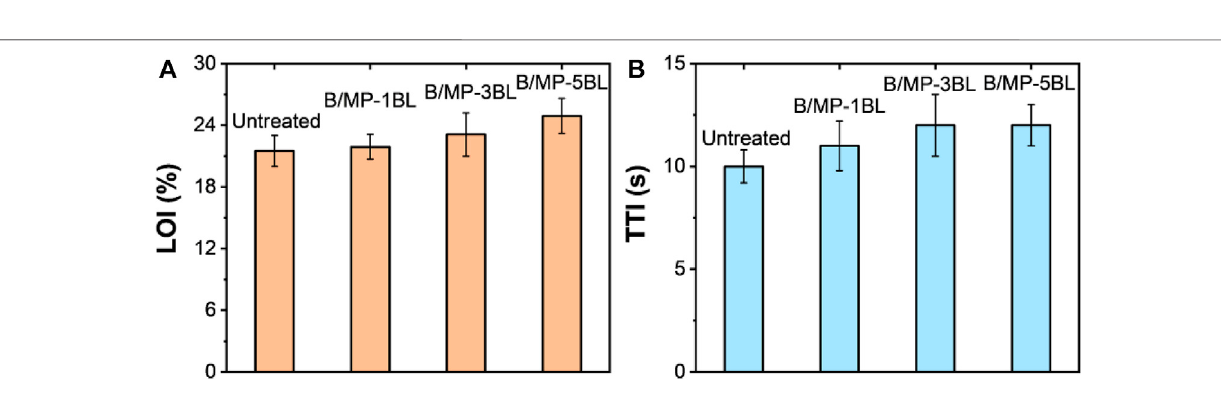
Frontiers in Materials |